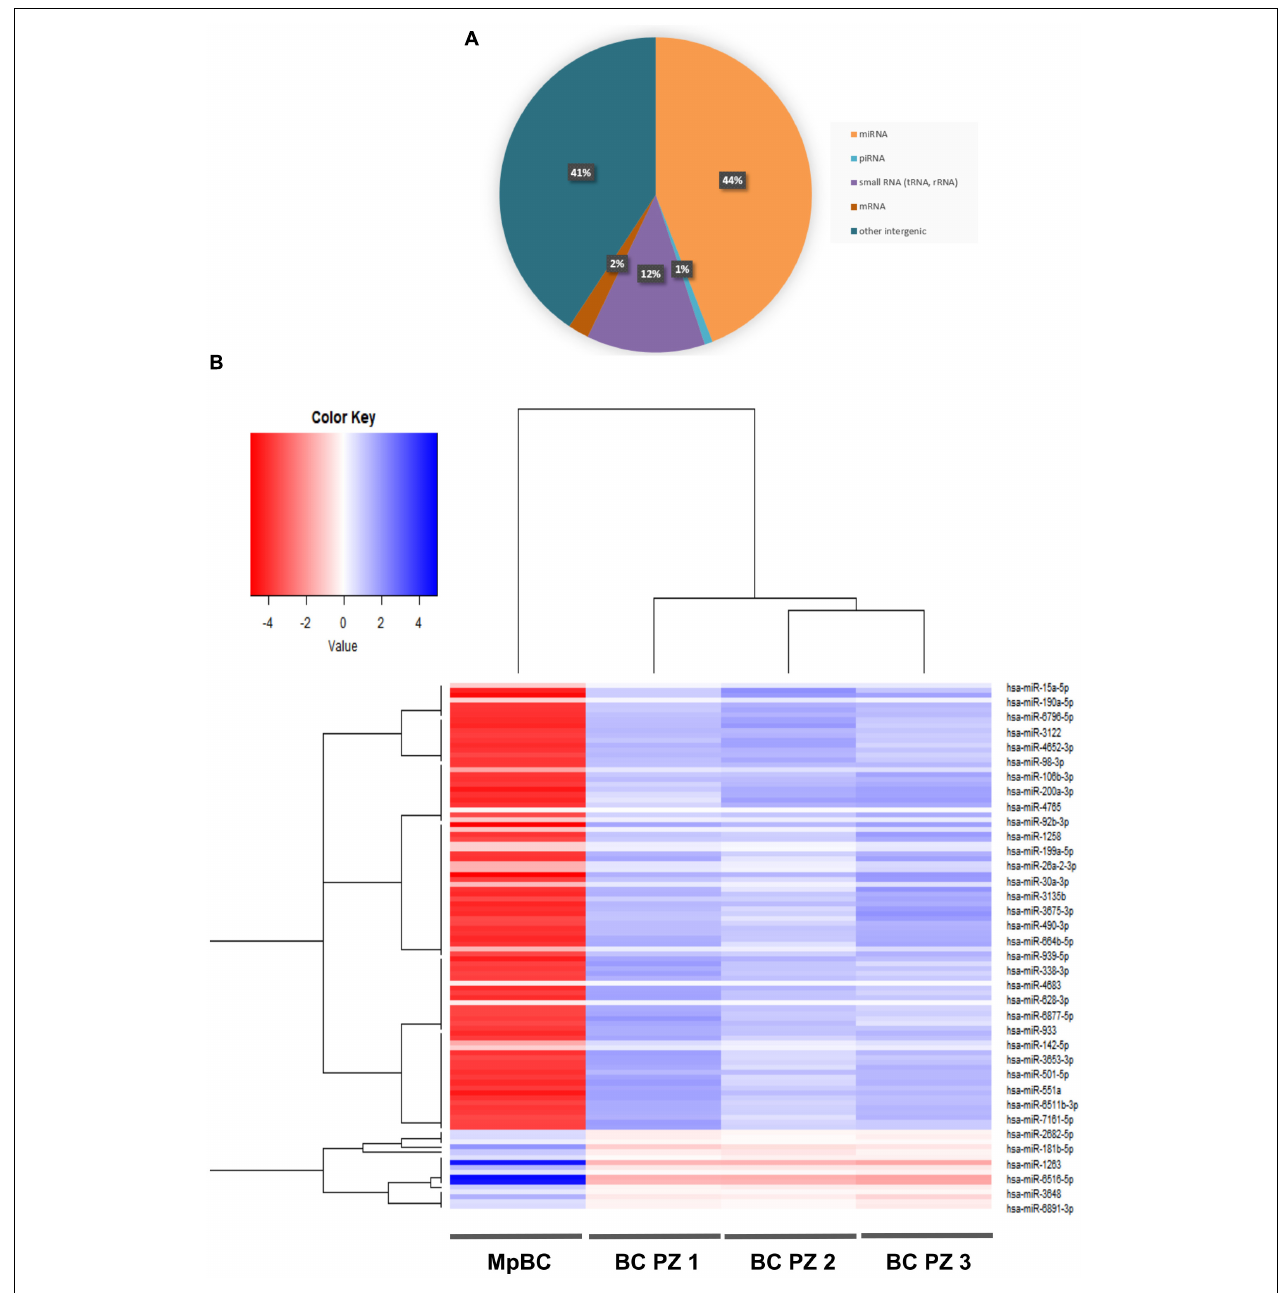
FIGURE 3 | (A) RNA species identified through next-generation sequencing in EVs of MpBC case. (B) Heat map showing the expression profile of the miRNA contained in EVs. The map shows the differentially expressed miRNAs ( T -test q -value < 0.05) in the EVs of MpBC patient plasma compared to miRNA EV cargo of three non-metaplastic metastatic breast cancer